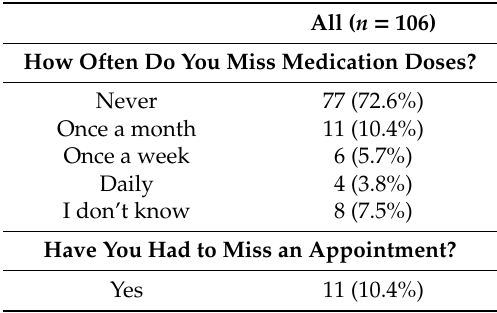
Table 3. Data on missed medication doses and appointments due to financial